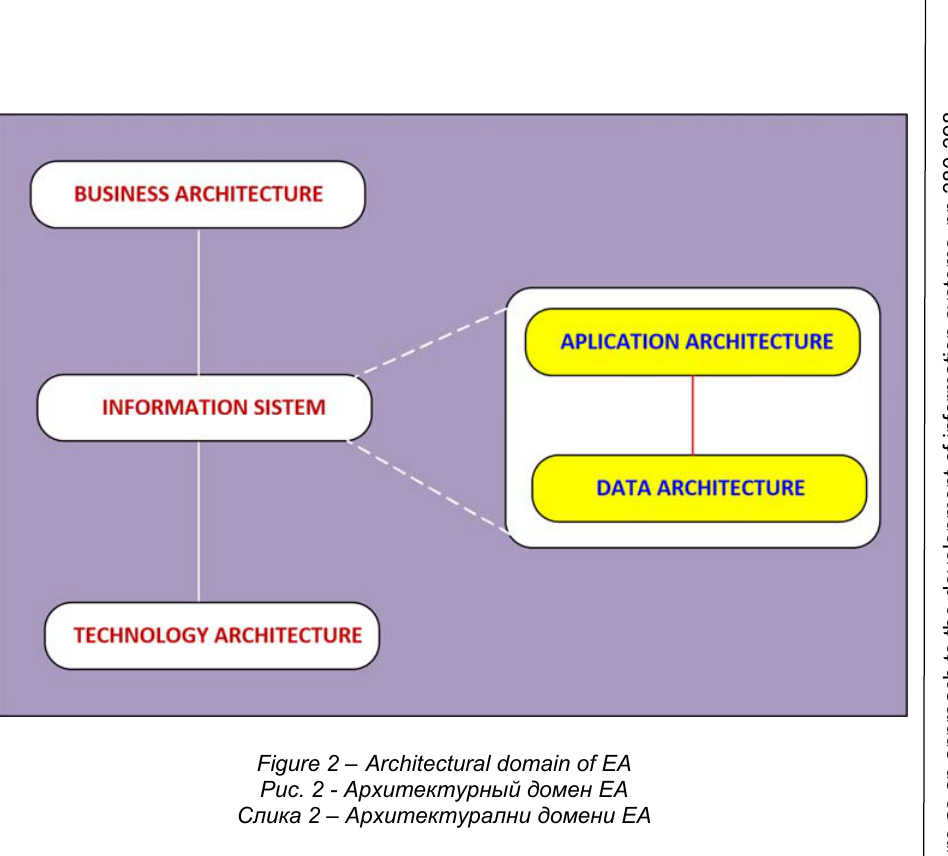
Figure 2 – Architectural domain of EA Puc. 2 - Архитектурный домен